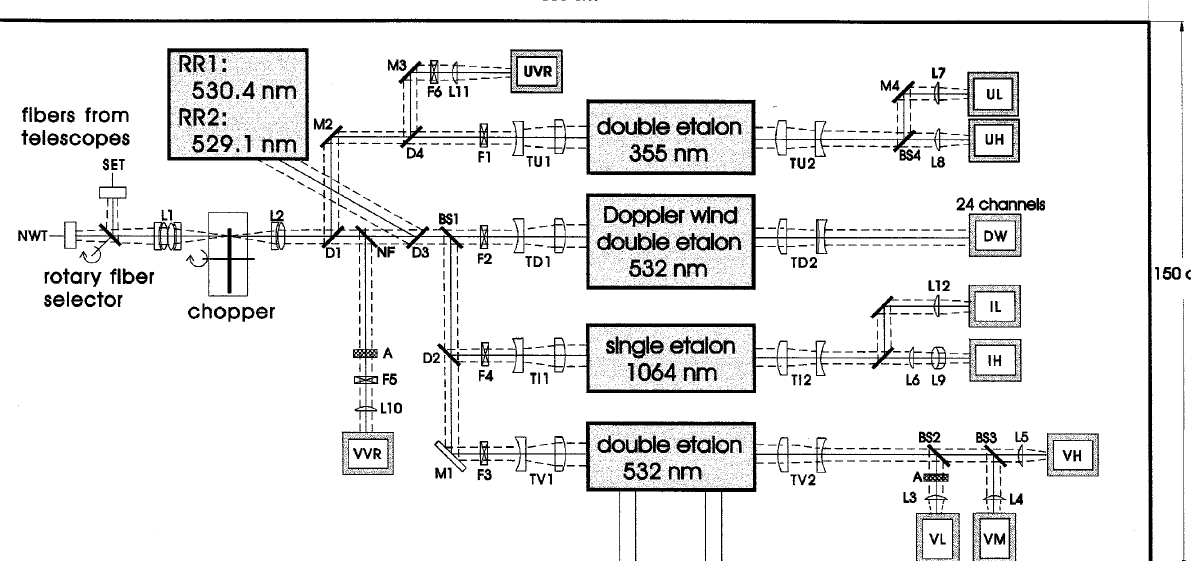
Fig. 5. Schematic of detection system. The photons collected by the NW- and SE-telescopes are transferred to the detection system via optical fibres. At the entrance ( left side ) the light from either fibre cable is alternately inserted into the optical path of the detection system by a rotary fibre selector . The light arriving from the fibres is re-focused by the relay lenses L1 on a fast mechanical chopper. Then it is collimated by lenses L2 and passes through the dichroic beam splitters D1 and D2 which divide the light into the three principal